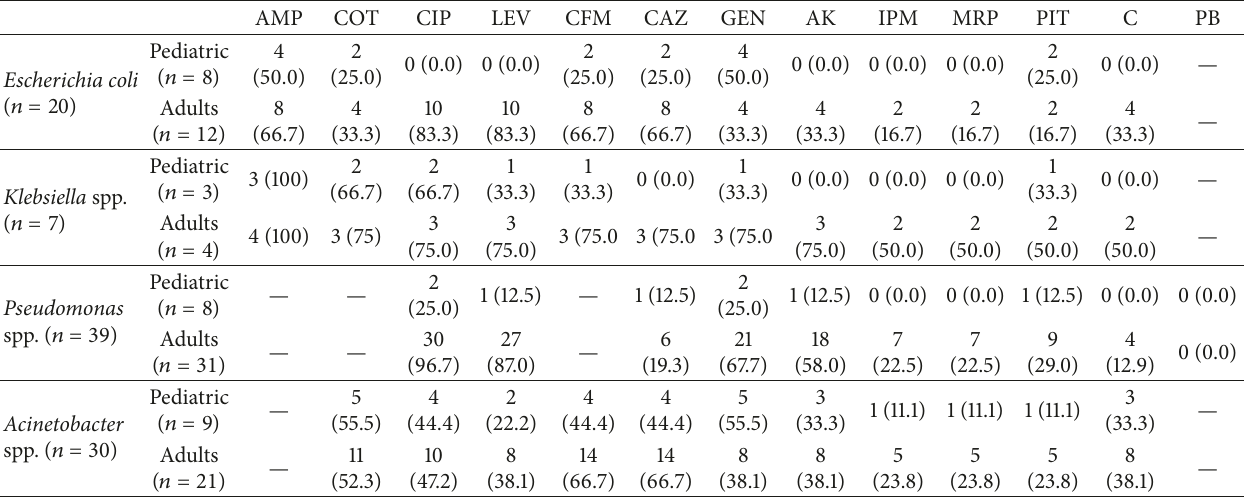
Table 3: Trends of antimicrobial susceptibilities of gram negative isolates (excluding Salmonella ) among pediatric and adult patients ( 𝑛 = 96